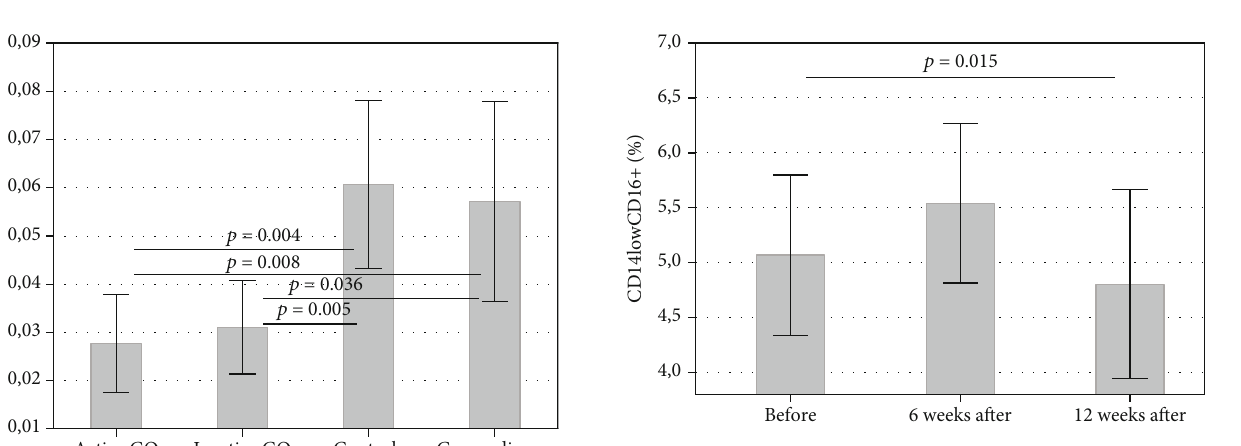
Figure 4: Percentage of CD14lowCD16+ at three (3) consecutive time points: before methylprednisolone treatment and after 6 weeks and after 12 weeks of the treatment. Statistical signi fi cance was found between the 1 st time point (i.e., before the treatment) and the last time point (after 12 weeks of treatment) ( p = 0 : 015 ), as evaluated by the ANOVA Friedman test and Wilcoxon matched-pair test. Data are presented as means ± standard deviation